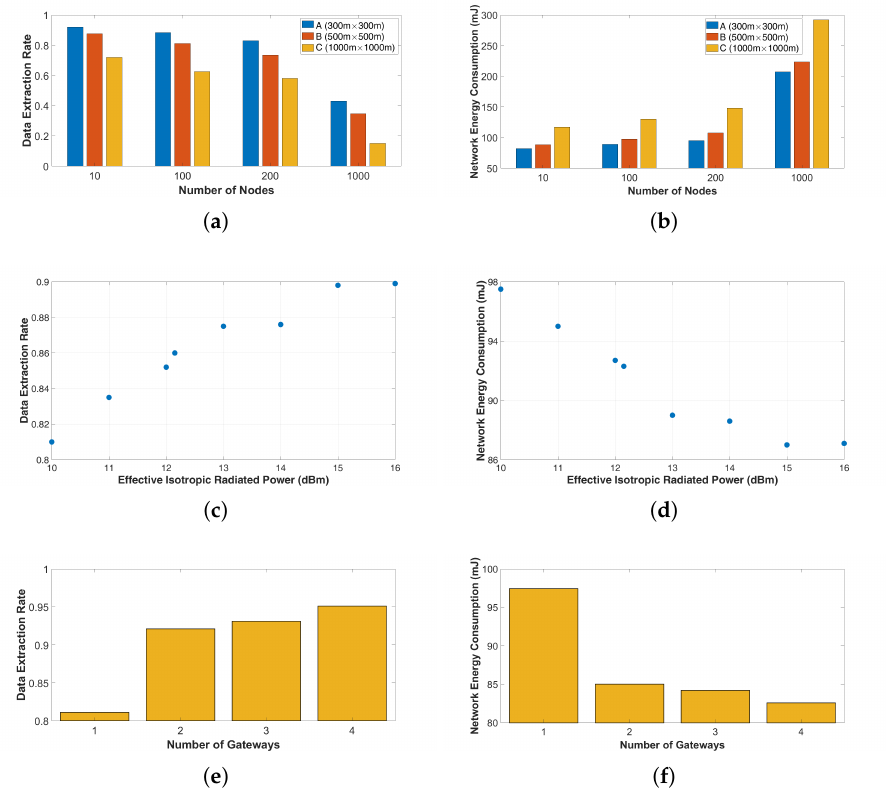
Figure 2. Log-normal shadowing model in rural environment. ( a ) DER as a function of the number of nodes; ( b ) NEC as a function of the number of nodes; ( c ) DER as a function of the EIRP; ( d ) NEC as a function of the EIRP; ( e ) DER as a function of the number of gateways; and ( f ) NEC as a function of the number of